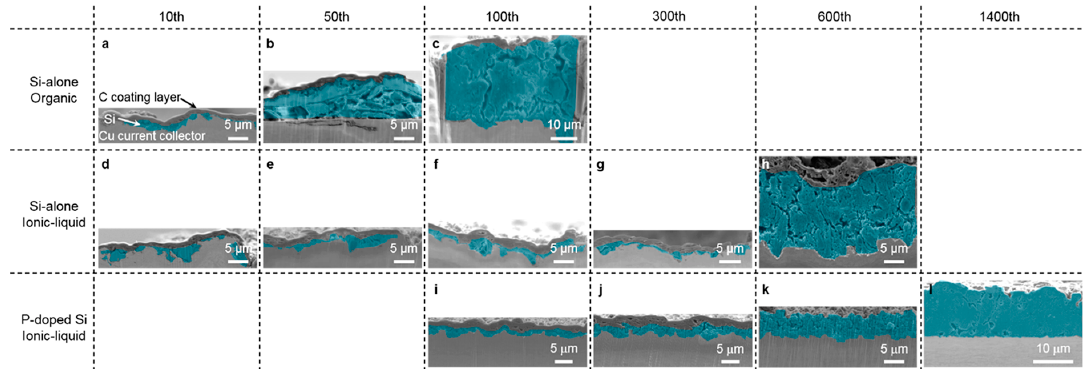
Figure 4. Cross-sectional SEM images of lithiated Si active material layers with a charge capacity limit of 1000 mAh g − 1 . The blue colored area indicates Si, while the topmost layer is a carbon coating. Reprinted with permission from Domi et al. [164]. Copyright 2019 American Chemical